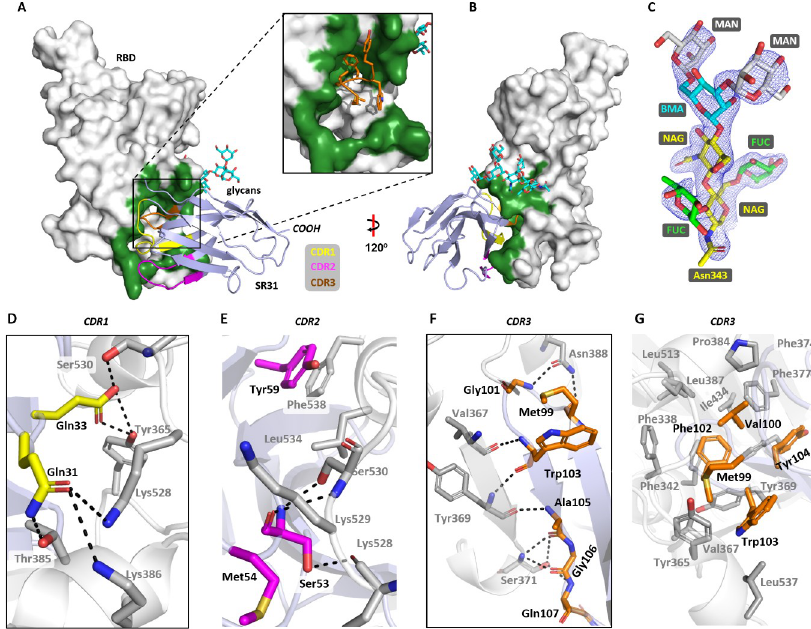
Fig 2. Crystal structure of the SR31-RBD complex. ( A ) The overall structure of SR31 (light blue) in complex with RBD (grey) which contains Asn343-linked glycans (cyan). The expanded view highlights a deep hydrophobic pocket (green) for CDR3 binding. ( B ) The overall structure viewed at a different angle. ( C ) 2 Fo-Fc map of the Asn343-linked glycans. MAN, mannose; BMA, β - D -mannose; FUC, fucose; NAG, N -acetylglucosamine. ( D-G ) Detailed interactions between RBD and the CDR1 ( D ), CDR2 ( E ), and CDR3 ( F, G ). The hydrophobic network formed between CDR3 (orange) and the hydrophobic pocket in RBD (grey) is shown in G . Residues from SR31 are labeled with black texts and residues from RBD are labeled with grey texts. Dash lines indicate hydrogen bonds or salt bridges within 3.6 Å .